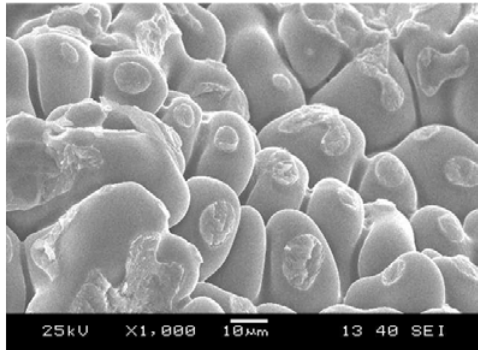
Figure 10. Enlarged view of area C in Figure 6.